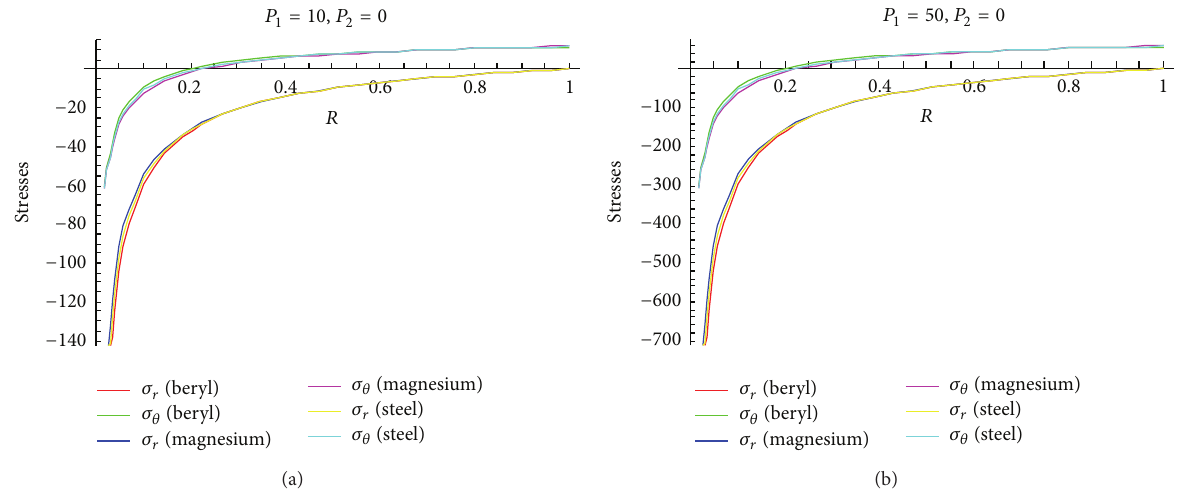
Figure 6: Transitional stresses when internal pressure 𝑃 1 = 10 and internal pressure 𝑃 1 = 50 (without external pressure).